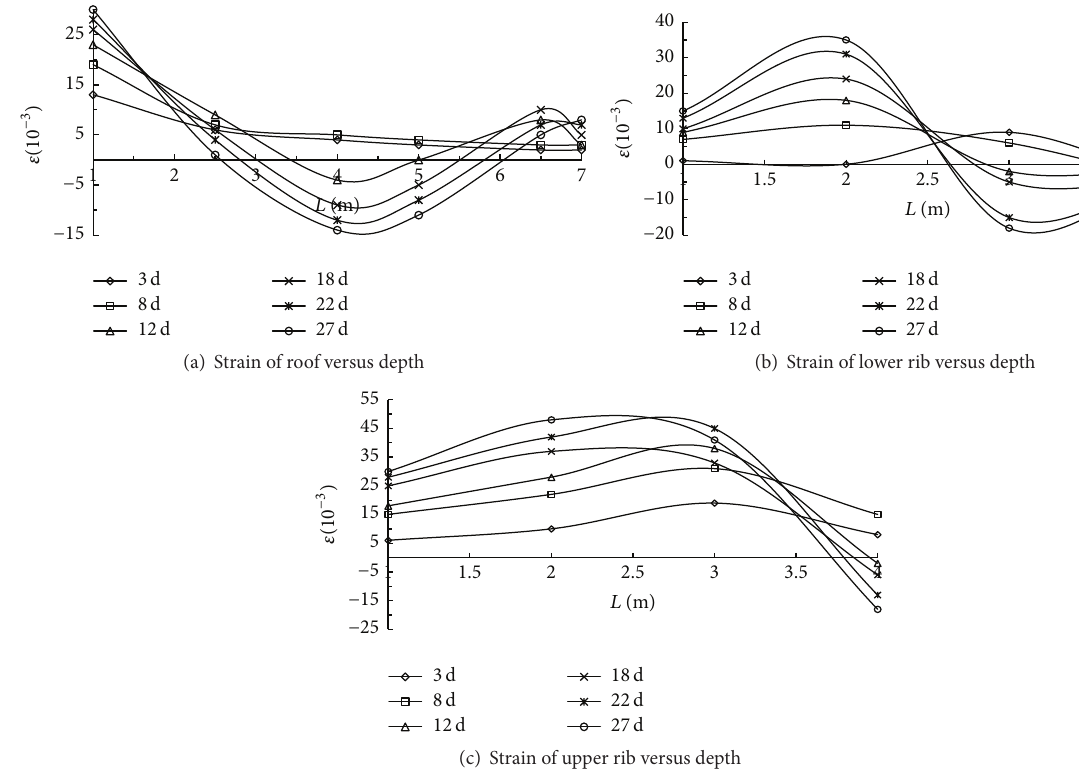
Figure 6: Strain of the roadway surrounding rock versus depth (recorded at different times).